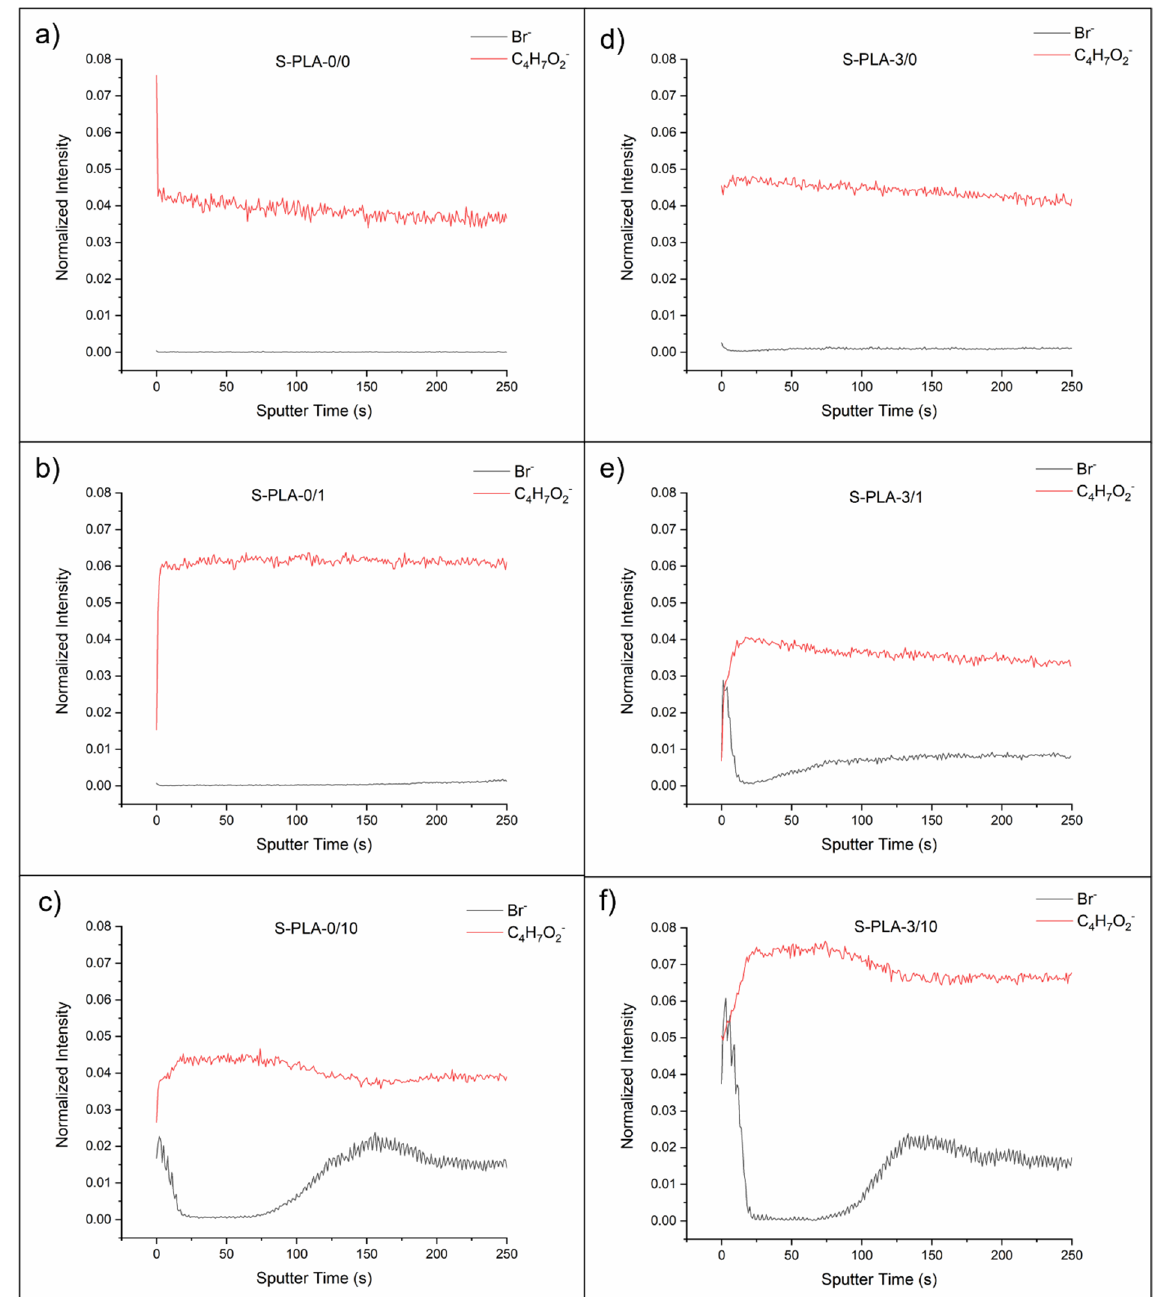
Figure 3. Depth profiles of S-PLA-0/0 ( a ), S-PLA-0/1 ( b ), S-PLA-0/10 ( c ), S-PLA-3/0 ( d ), S-PLA-3/1 ( e ) and S-PLA-3/10 ( f ) films .